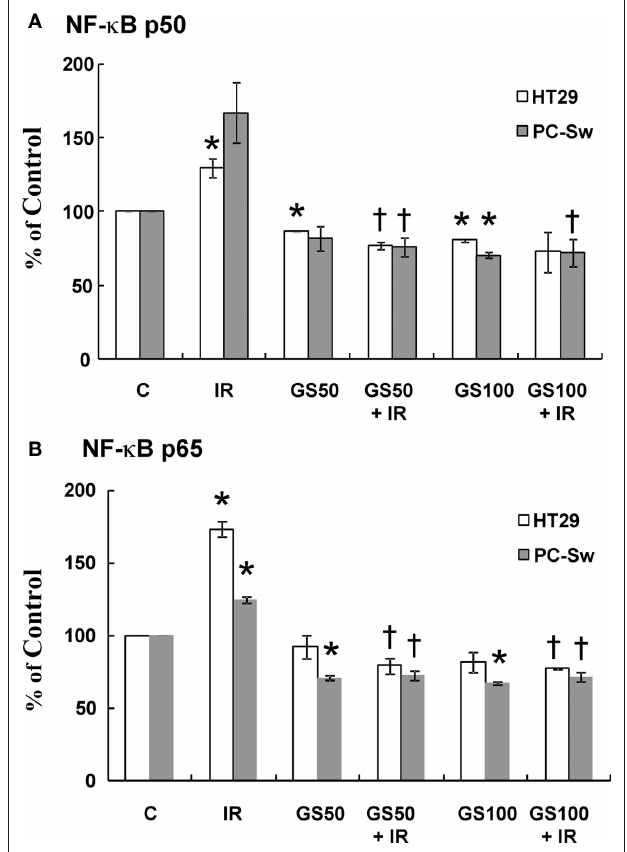
FiguRe 6 | NF- κ B p50 and p65 activity in HT29 and PC-Sw cells measured after gS and iR exposure. Cells were pre-treated with GS (50 and 100 μM) for 24 h alone, exposed to 10 Gy alone, or incubated with GS and irradiated with 10 Gy and analyzed for NF- κ B activation 3 h post-IR using a nuclear transactivation assay for NF- κ B p50 (A) or NF- κ B p65 (B) . * p values < 0.05 compared to control, † p values compared to